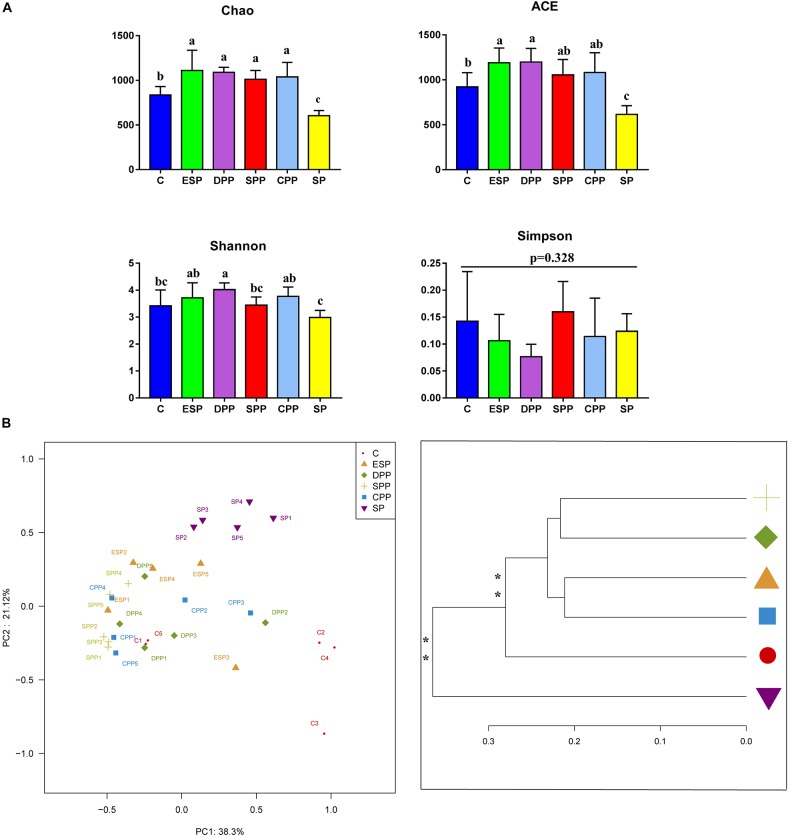
Richness and diversity of cecum microbiota. (A) Alpha diversity. (B) Principal coordinate analysis and clustering analysis. The data were analyzed by one-way ANOVA, and means were compared by Tukey’s t-test. The “a, b, c” letters indicate significances (P < 0.05). The MANOVA significance was also indicated: *P < 0.05; **P < 0.01. C, casein; CPP, cooked pork protein; DPP, dry-cured pork protein; ESP, emulsion-type sausage protein; SP, soy protein; SPP, stewed pork protein.